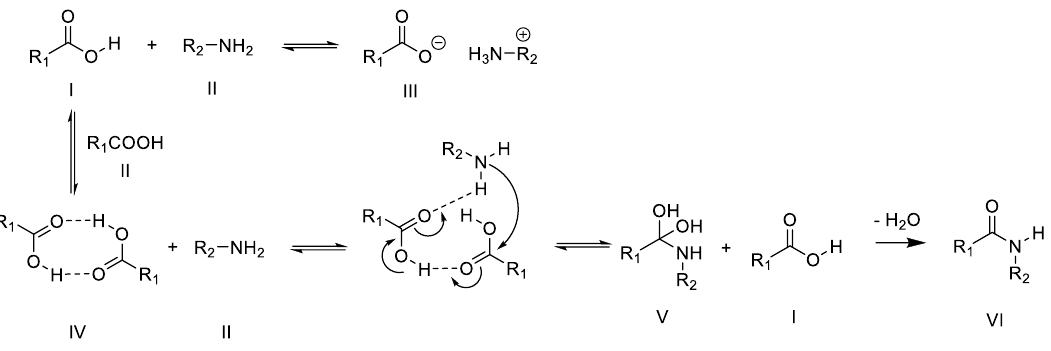
Figure 1. Mechanism of the thermal amidation of carboxylic acids.